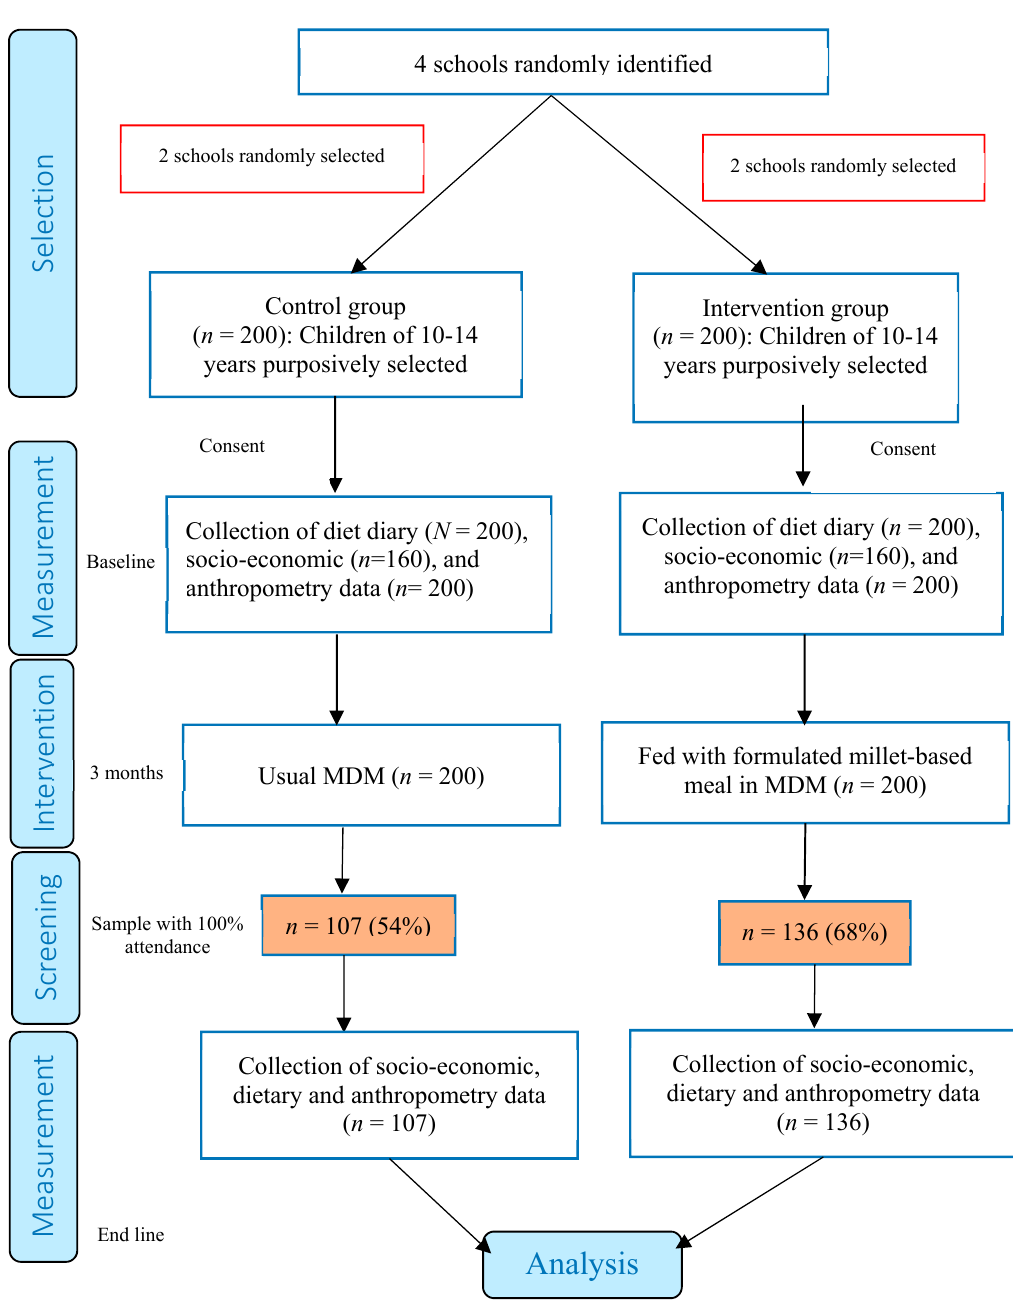
Figure 1. A flow diagram for the study.